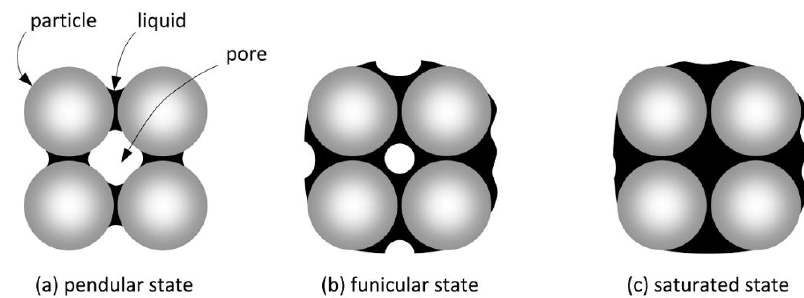
Figure 5. The states associated with agglomeration of powders due to a wetting liquid 18